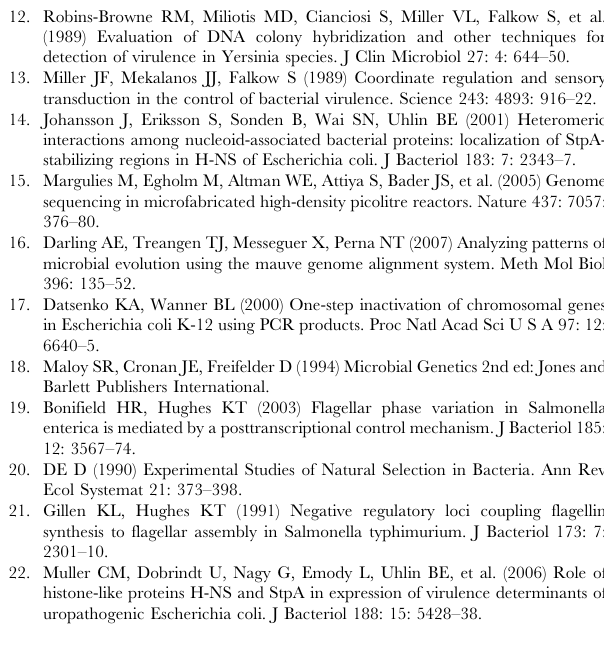
Table S3 Unique Mutations identified in JB124 relative to LT2. Table S4 Primers